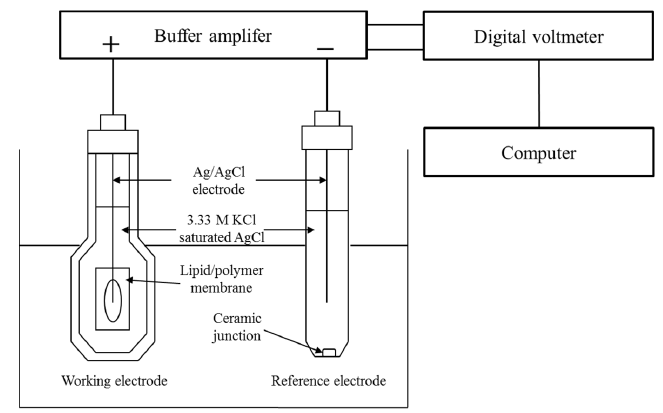
Figure 2. The measurement system of the taste sensor.